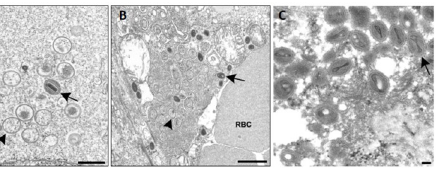
Fig 4. Electron microscopic images of VARV in a humanized mouse. Subset of select tissues from VARV challenged humanized-mice (hu-BLT, hu-CD34+ and hu-PBMC) were examined by transmission electron microscopy. (A) Hepatocyte with multiple spherical, diffuse immature particles (arrowhead) and a single condensed mature particle (arrow). Bar, 500 nm. (B) Sinusoidal endothelial cell in the liver with immature (arrowhead) and mature (arrow) VARV particles. RBC, red blood cell. Bar, 1 um. (C) Human fetal thymic allograft containing mature virions with a characteristic dumbbell-shaped nucleoid (arrow). (BLT-8, low dose, day of death 13 dpi). Bar, 100